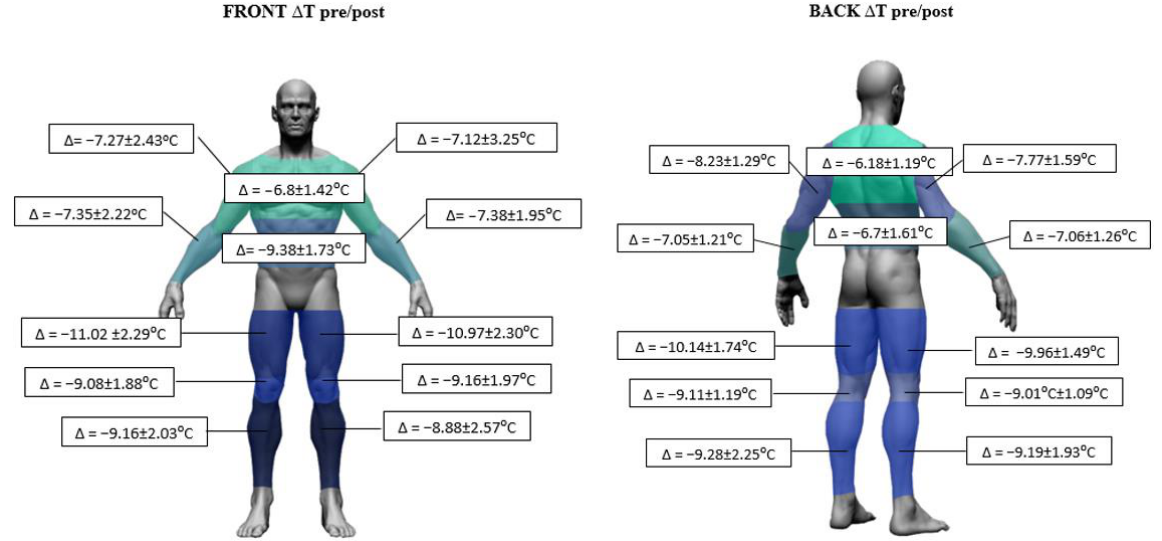
Figure 3. Mean values of skin temperature changes in selected areas of the body after the PBC procedure compared to the baseline temperature.